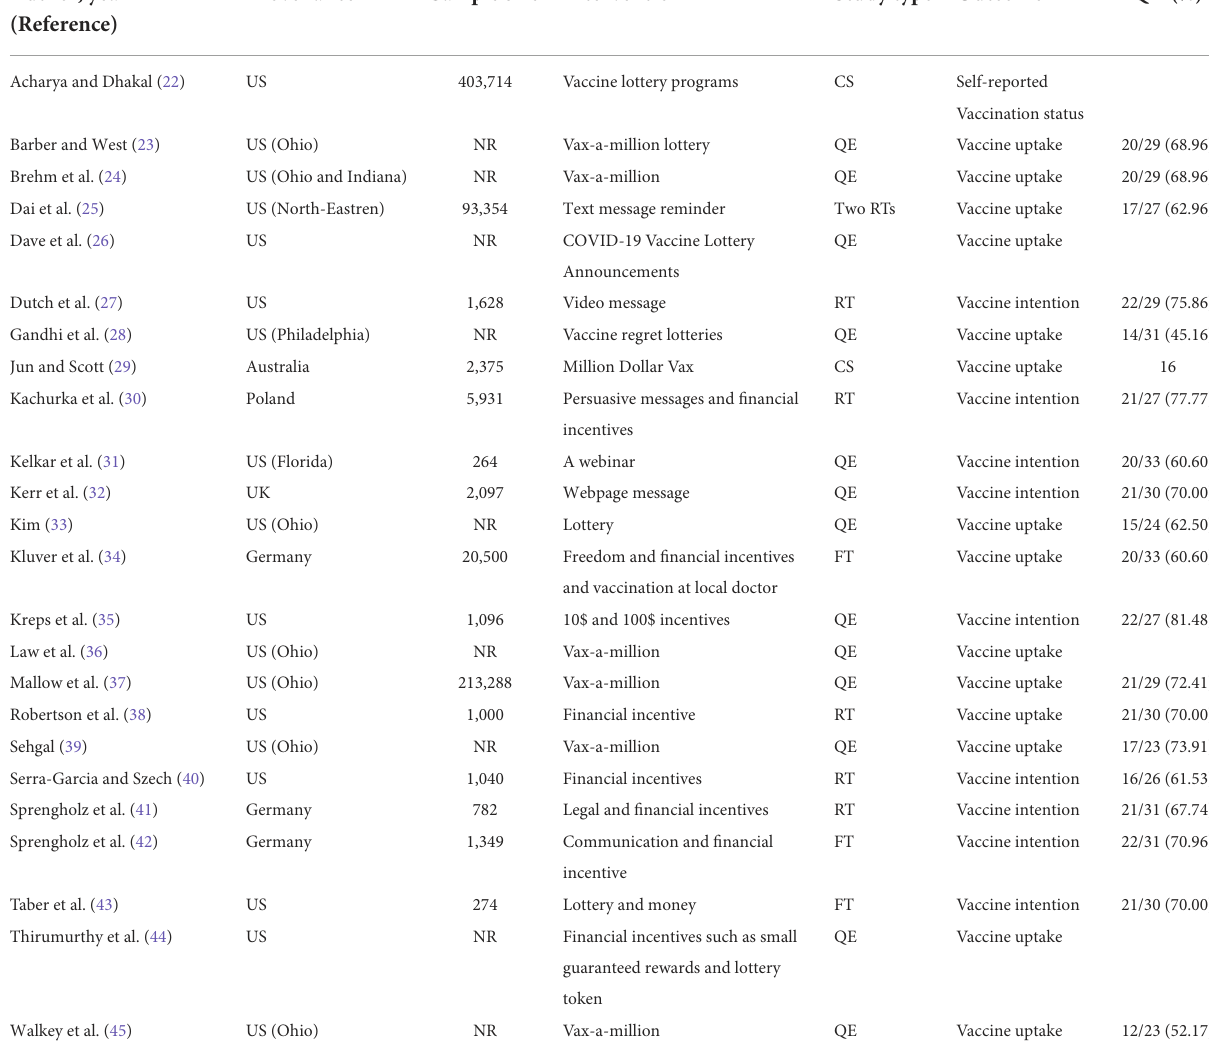
TABLE 1 Characteristics of included